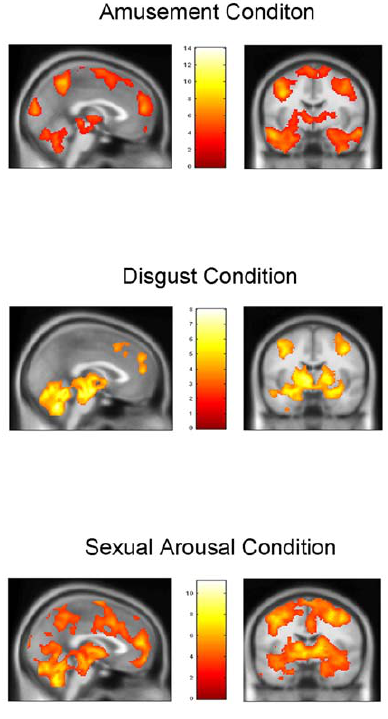
Figure 1. Sagittal and coronal slices across the main areas of supra-threshold areas of activation for the ‘Amusement condition minus Neutral’, ‘Disgust condition minus Neutral’, and ‘Sexual arousal condition minus Neutral’ contrasts. Note the similarities between contrasts. All contrasts clearly show involve- ment of medial prefrontal cortex, supplementary motor area, hypo- thalamus, thalamus, amygdala, ventral insula, and cerebellum.